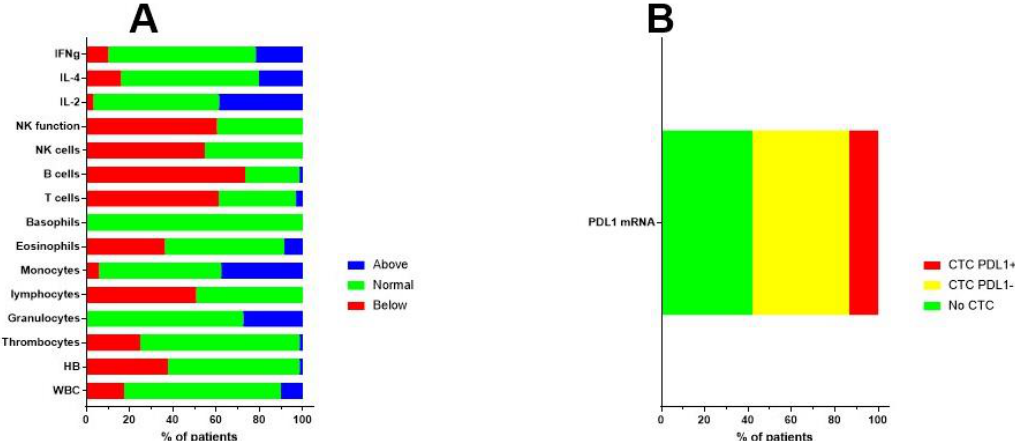
Figure 2. Immune variables before the start of immunotherapy. ( A ) Before the start of individualized multimodal immunotherapy, blood was drawn and sent to the routine clinical lab for analysis. Different immune variables are shown. The percentages of patients with values above (blue), within (normal, green), or below (red) the normal range are shown. ( B ) Blood was also sent to Biofocus in order to detect circulating tumor cells based on mRNA expression of GBM-related oncogenes. When cells were detected, the RNA expression for PDL1 was subsequently analyzed and cells were defined as negative (yellow) or positive (red) for the expression of mRNA for PDL1.